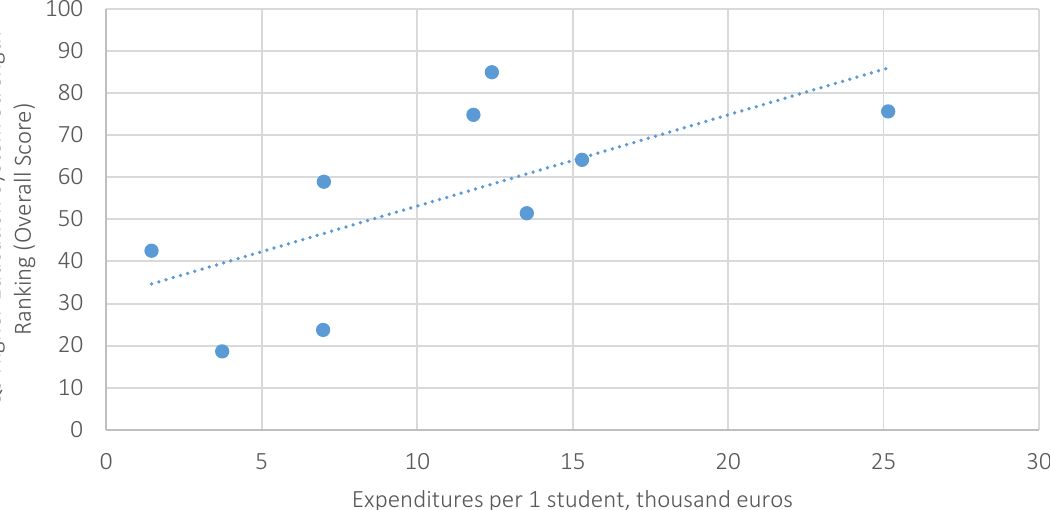
Figure 2. Analysis of the correlation between the amount of expenditure per student and the QS World University